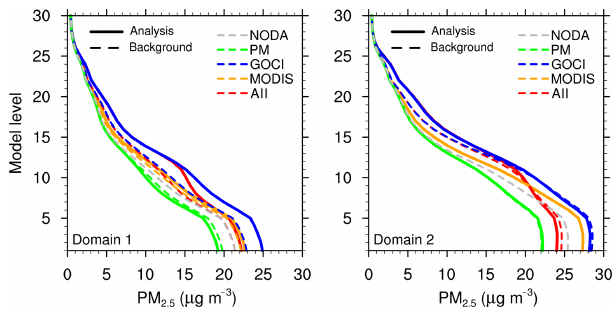
Figure 8. Same as Fig. 7, except for PM 2 . 5 in both